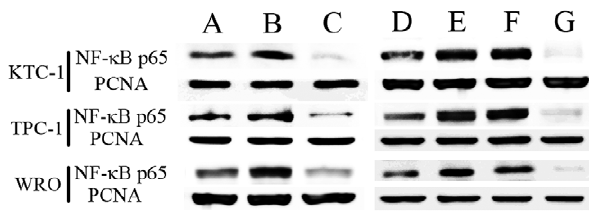
Figure 6. Effect of different treatments on apoptotic cascade. KTC-1 cells were left untreated as controls ( A ), or treated with 20 MBq/ ml 131 I ( B ), 5 m mol/L Bay 11-7082 ( C ) or combination ( D ) for 24 hours. Then whole cell lysates were examined by Western blot for caspase 3 and PARP. In the second set of experiments, KTC-1 cells were treated with no oligonucleotide control ( E ), scrambled oligonucleotides ( F ) or p65 siRNA transfection ( G ) first. Then these three groups of cells were exposed to 131 I (20 MBq/ml) for 24 hours ( H–J ). Caspase 3 and PARP protein levels were examined by Western blot. b -actin was used as a loading control. Similar results were obtained in three independent experiments.